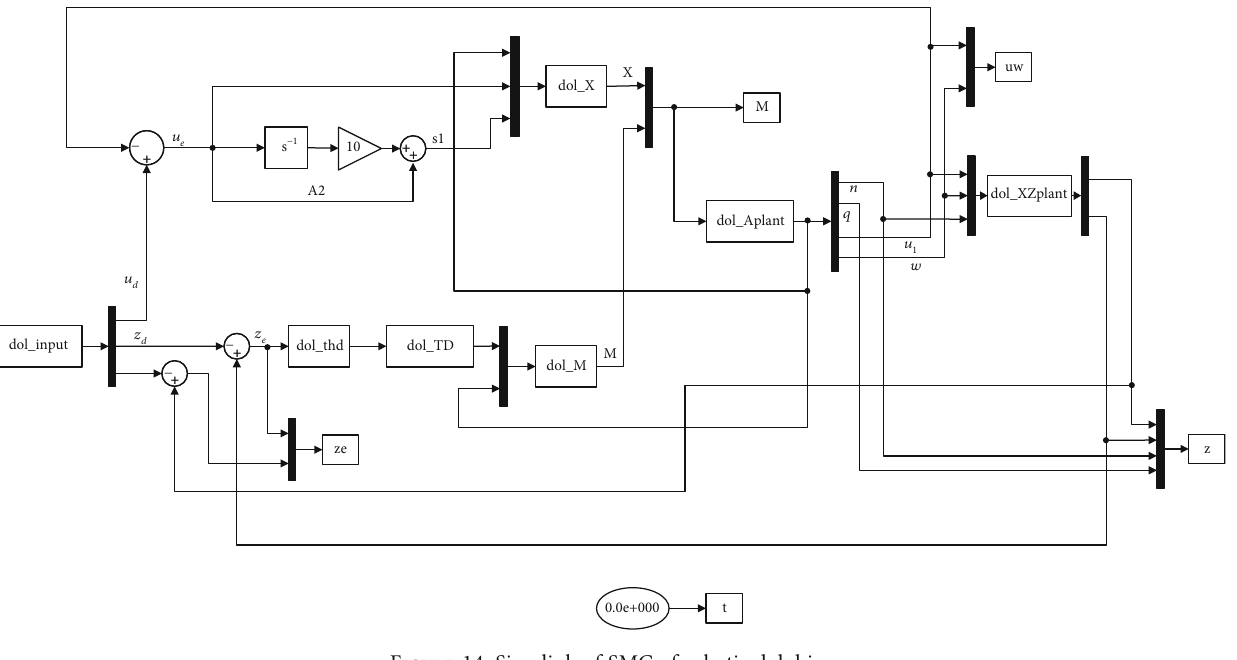
Figure 14: Simulink of SMC of robotic dolphin.